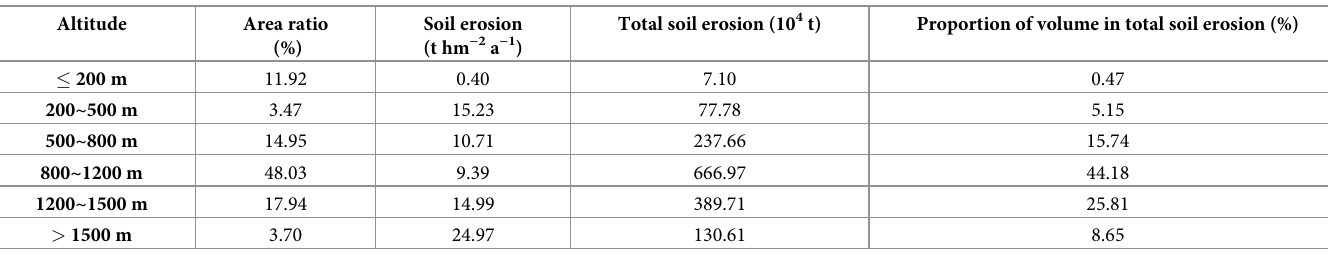
Note: Altitude range class standard reference [64].’